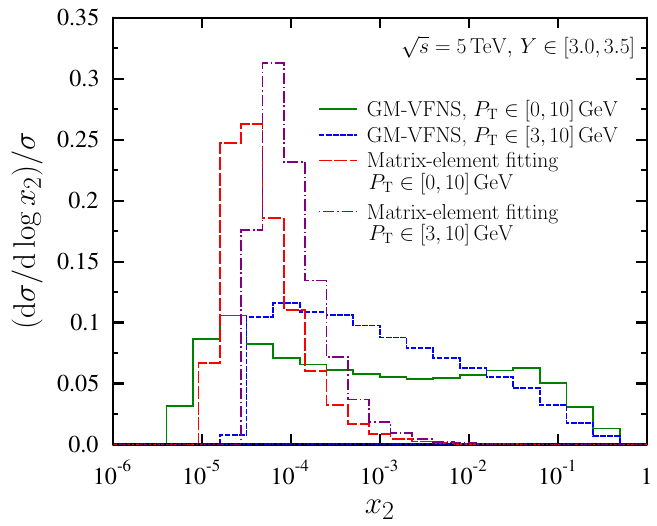
Figure 13 . Contributions to di(cid:11)erential D 0 cross section from di(cid:11)erent values of x from the GM-VFNS in P T ranges of [0 ; 10] GeV (solid green) and [3 ; 10] GeV (short-dashed blue) and from matrix-element (cid:12)tting approach for same P T ranges (long-dashed red and dot-dashed purple). are not visible in the distributions obtained with the matrix-element (cid:12)tting approach as it assumes leading-order partonic kinematics and, in particular, a naive